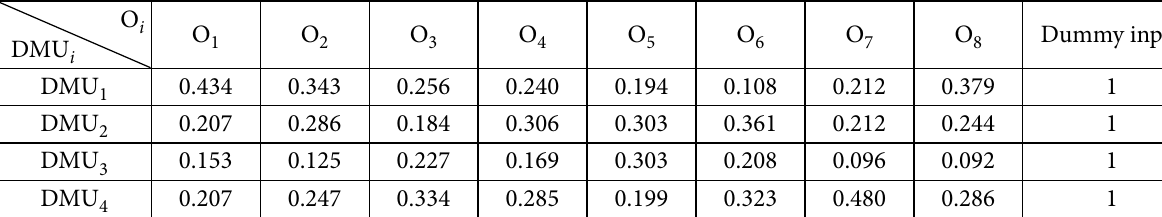
Table 8. DEA parameters when all weight criteria and sub-criteria are equal (scenario